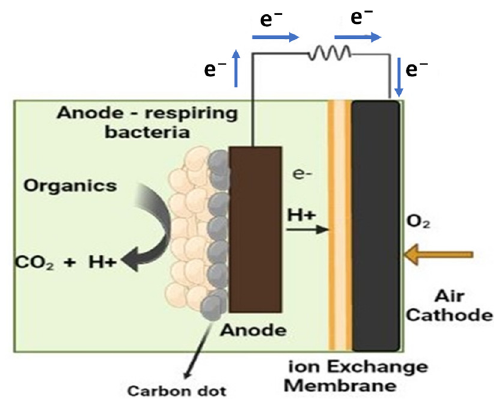
Figure 1. A schematic diagram of the MFCs using CDs as a catalyst on an anode.